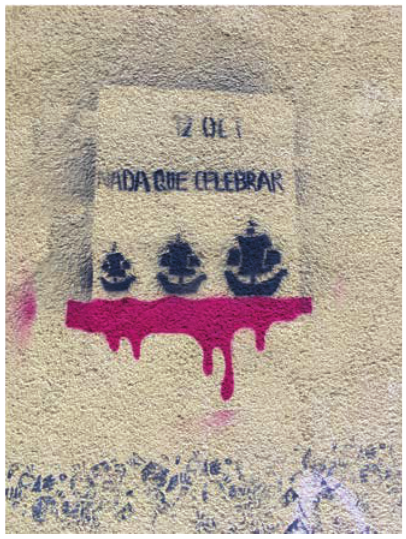
definition, it has the advantage of being easy